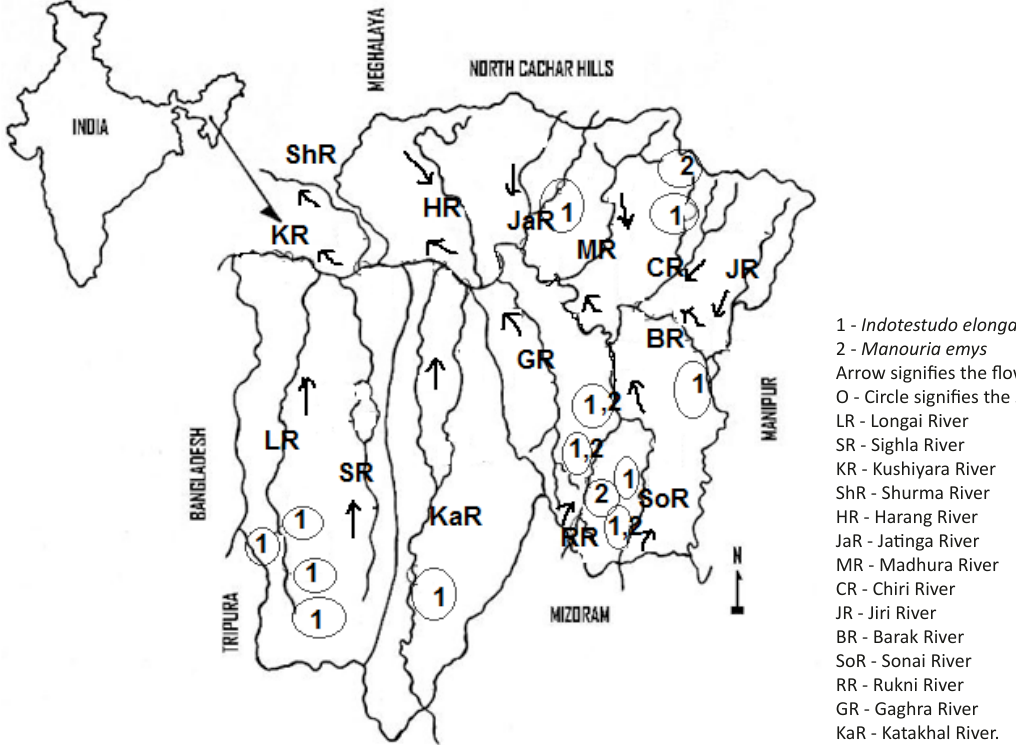
Figure 1. Map of Barak Valley shows sites of occurrence of terrestrial tortoises.